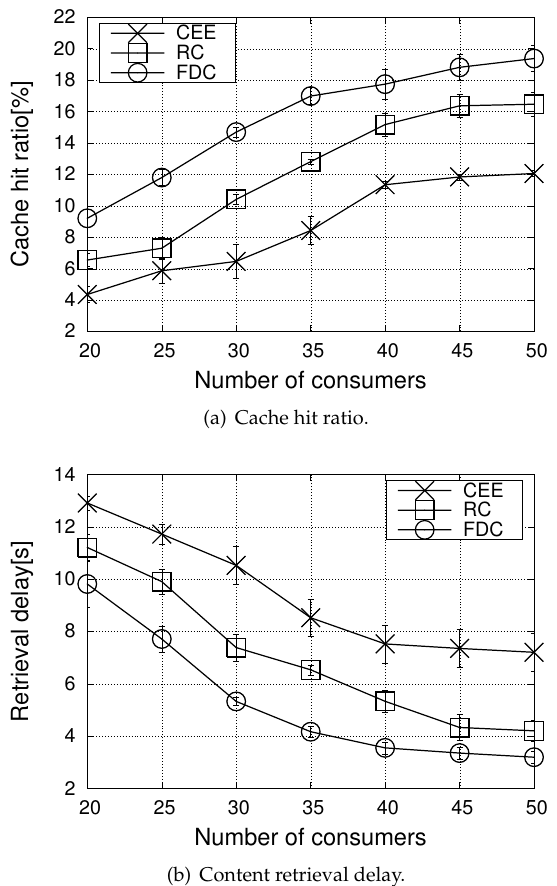
Figure 7. Performance metrics in the highway scenario, when varying the number of consumers ( α =